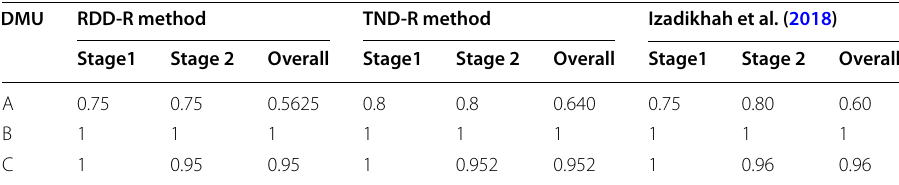
Table 2 Numerical comparison between the TND-R and RDD-R methods and Izadikhah et al. (2018) DMU RDD‑R method TND‑R